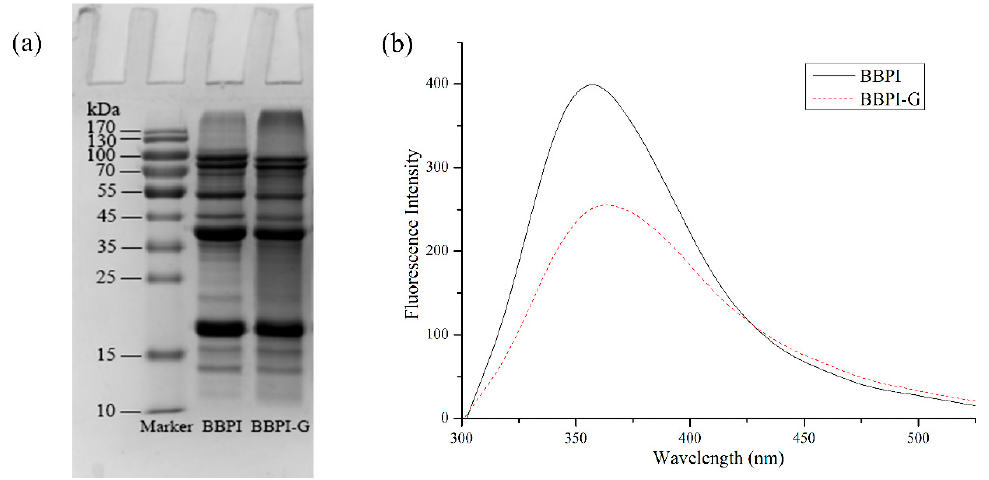
Figure 1. Characterization of BBPI-G. SDS-PAGE ( a ) and Fluorescence spectra ( b ) of BBPI and BBPI-G.